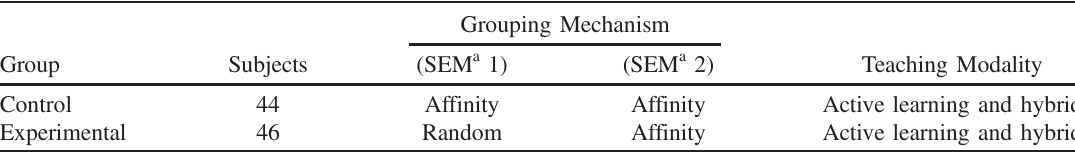
TABLE IV. Quasiexperimental design and interventions: Longitudinal analysis.